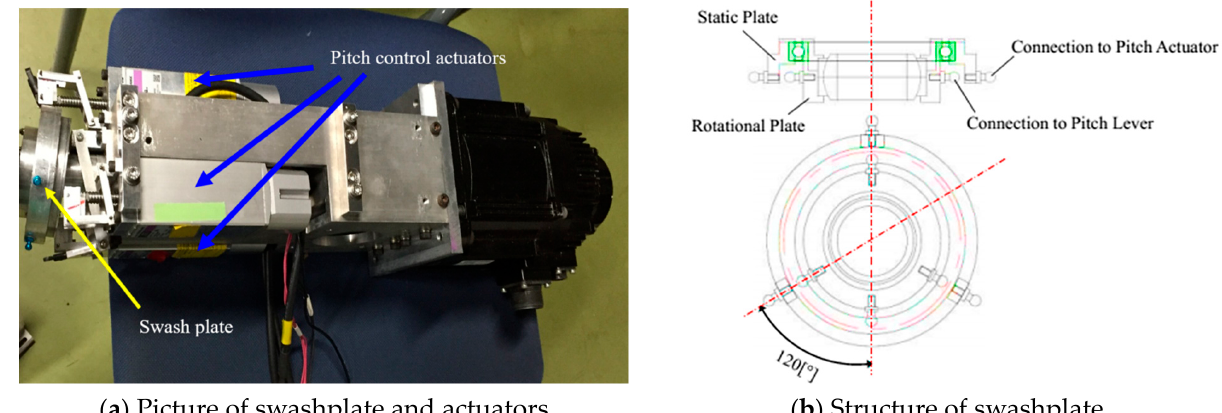
Figure 3. Swashplate equipment for controlling the pitch angle.